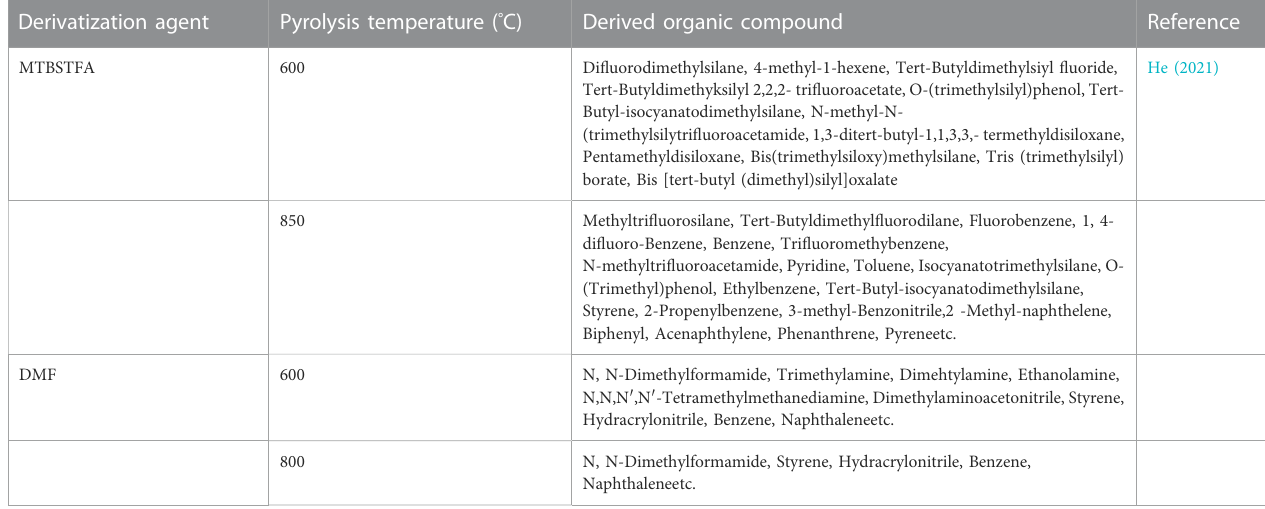
TABLE 2 Lab based fl ash pyrolysis (at > 500 ° C) products of derivatization agents MTBSTFA and DMF (He, 2021). Derivatization agent Pyrolysis temperature ( ° C) Derived organic